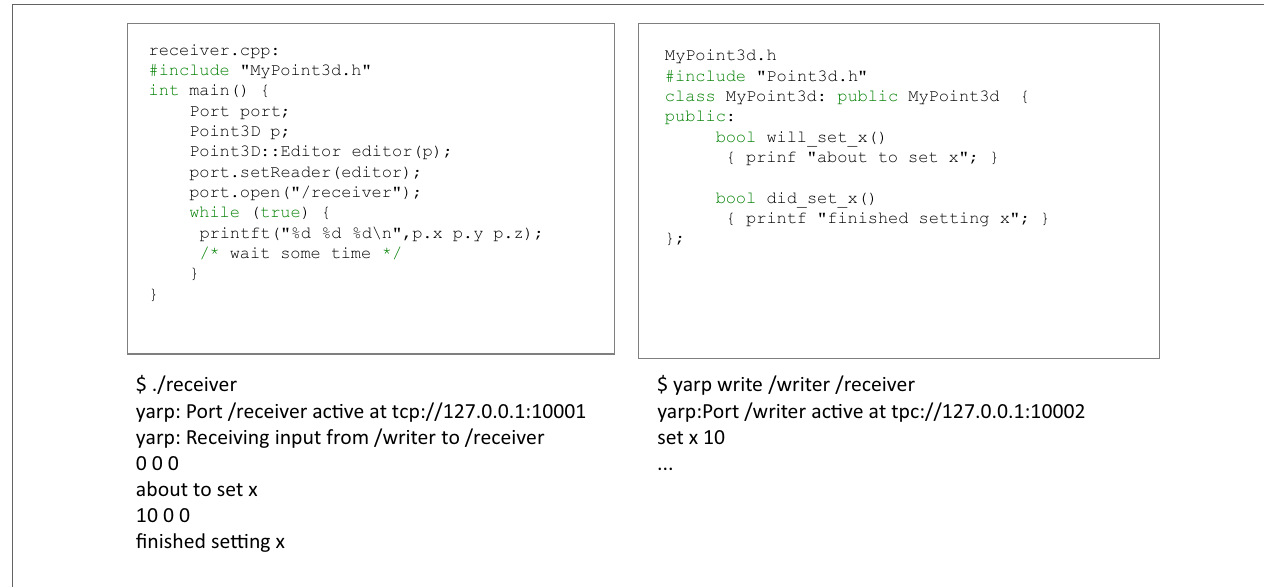
FigUre 3 | The Editor. For each new type, the Thrift compiler generates an Editor object, which provides methods for manipulating only a subset of the type. The listing on the top-left shows how to use the Editor . An instance of the Editor is connected to Point3D (see Figure 2 ) and to the module’s Port object ( i.e. port ). Messages received by port are parsed by the Editor , which decodes and handles them appropriately. Top-right: optionally, the user can define call-back functions that are invoked before and after data is modified. Bottom: we show how the value of the field x in Point3D can be modified by sending text messages to a Port (left: